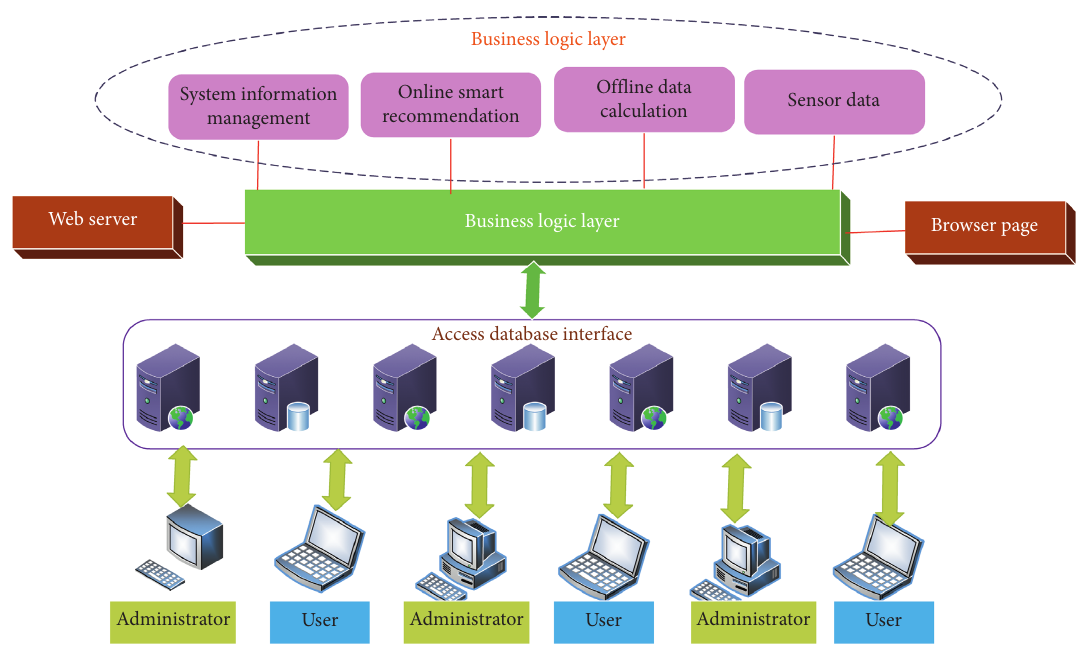
Figure 3: Overall system architecture.